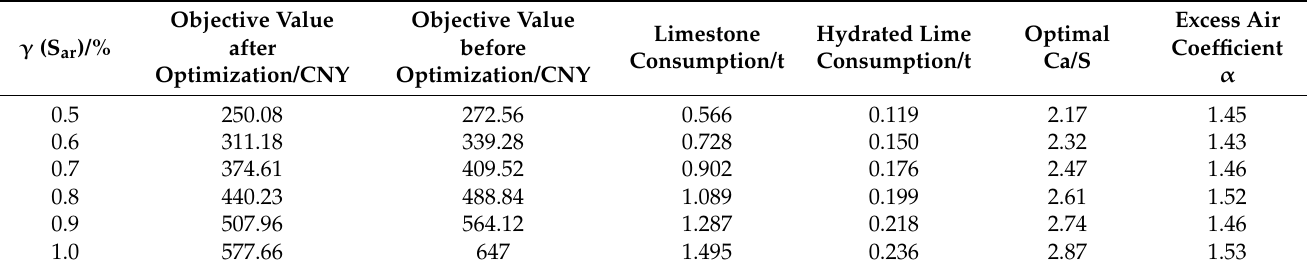
Table 2. The best operation for different sulfur bases.